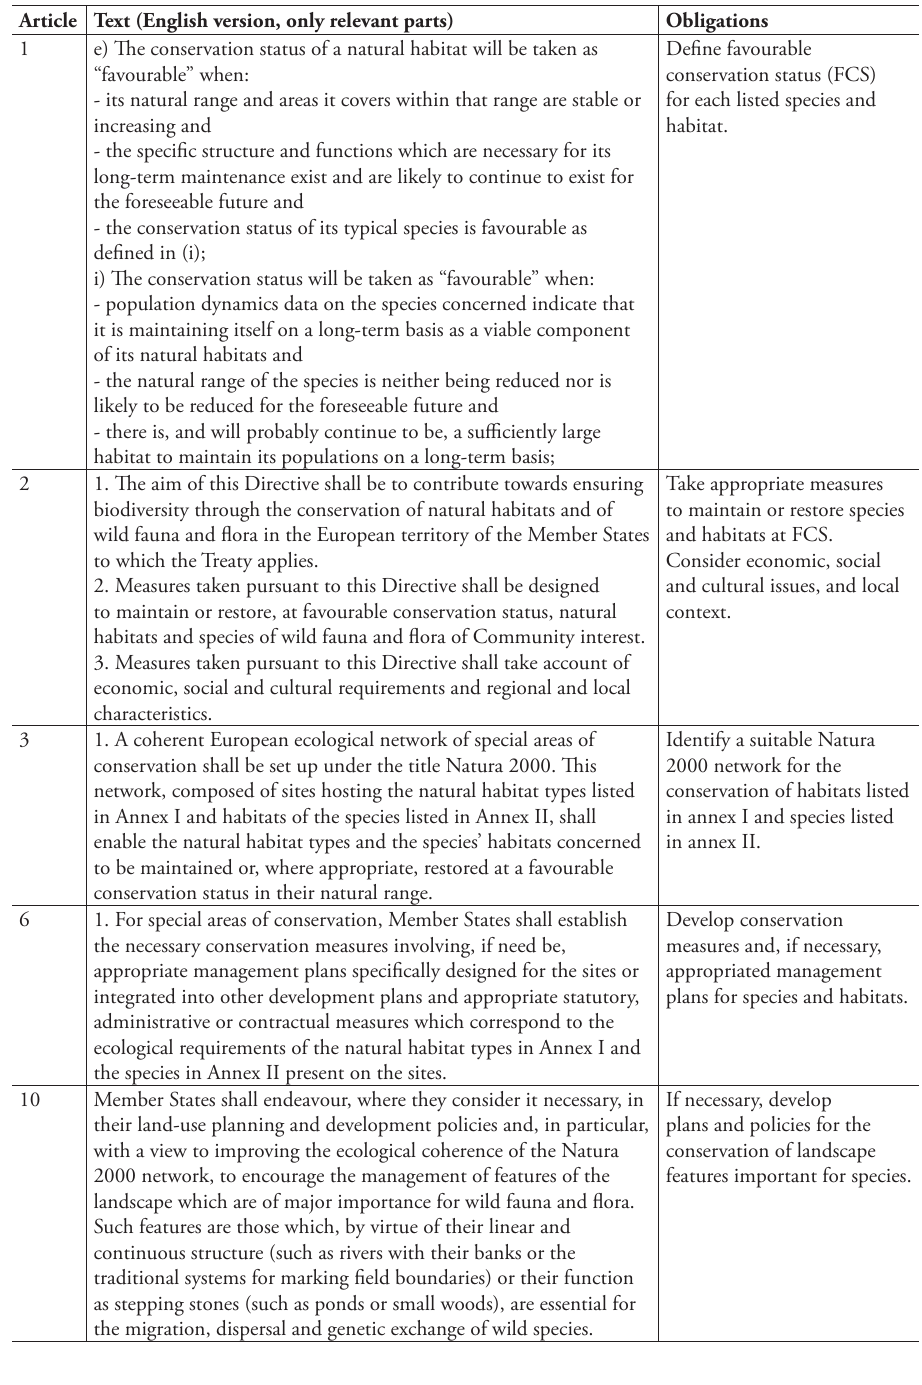
Table 1. Obligations arising from the Habitats Directive for the conservation of animal species and